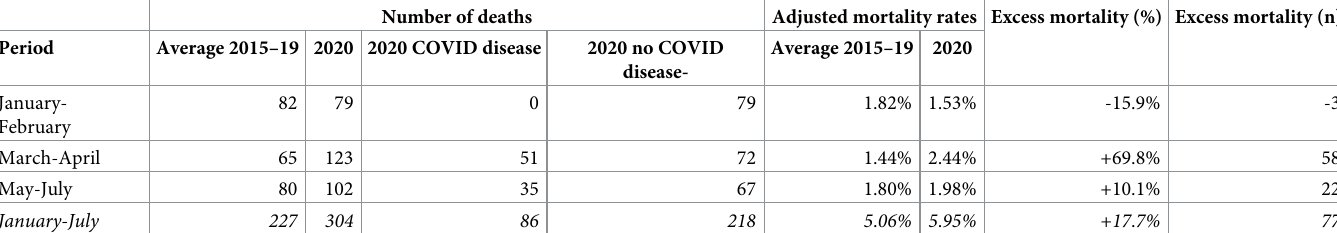
Table 3. Excess mortality of CKD patients in 2020 with respect to the average mortality of 2015–19.